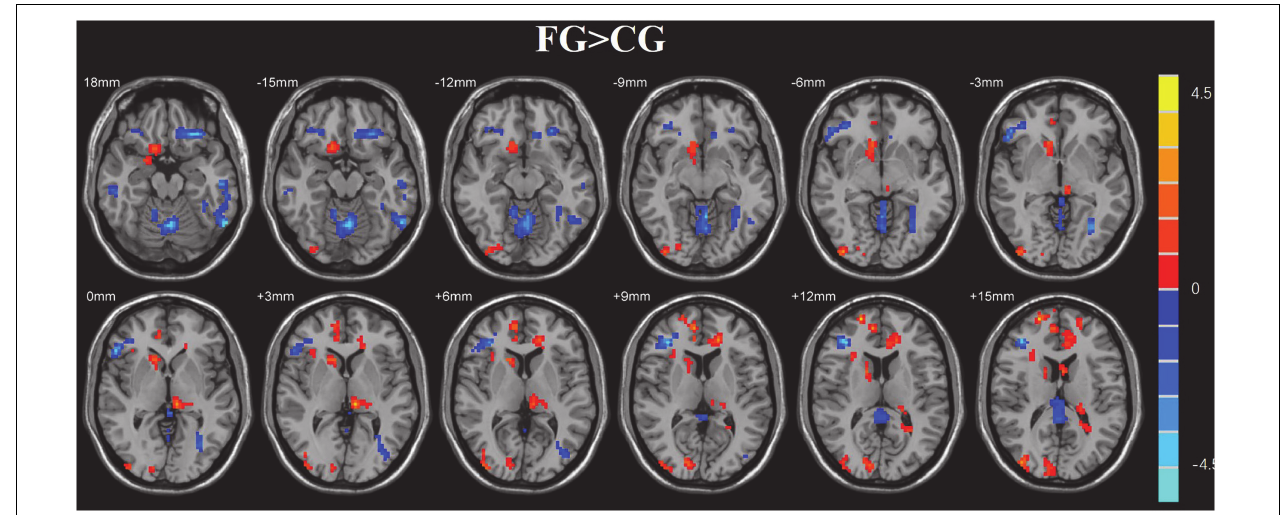
FIGURE 7 | Regions with altered ReHo score in the experimental group after rtfMRI-NF training. The score of ReHo maps increased after the training were found in the left anterior cingulum gyrus, left superior parietal gyrus, left inferior parietal gyrus, right frontal gyrus, right angular gyrus, right precuneus, and superior frontal gyrus. The score of ReHo maps decreased after the training were found in the left parahippocampal gyrus, left hippocampus, middle temporal gyrus, right caudate nucleus, right fusiform gyrus, insula, and right postcentral gyrus (AlphaSim corrected p < 0.01).